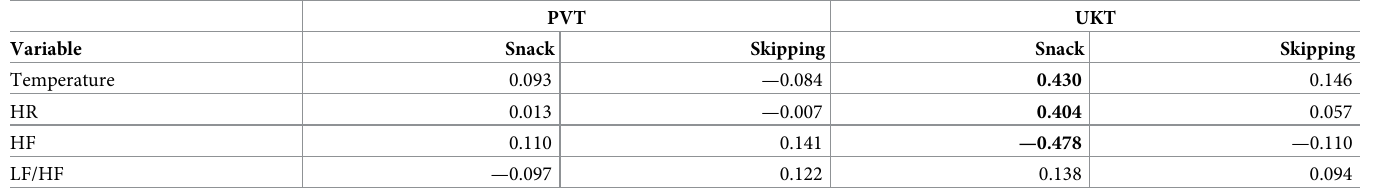
Table 3. Correlations of after eating (04:00 to 09:00) performance outcomes with temperature and autonomic nervous system parameters. PVT UKT Variable Snack Skipping Snack Skipping Temperature 0.093 —0.084 0.430 0.146 HR 0.013 —0.007 0.404 0.057 HF 0.110 0.141 —0.478 —0.110 LF/HF —0.097 0.122 0.138 0.094 Significant correlations are highlighted in bold (p <